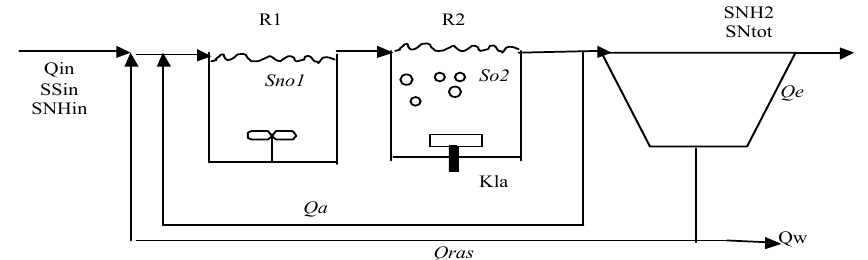
Figure 2. Schematic representation of the